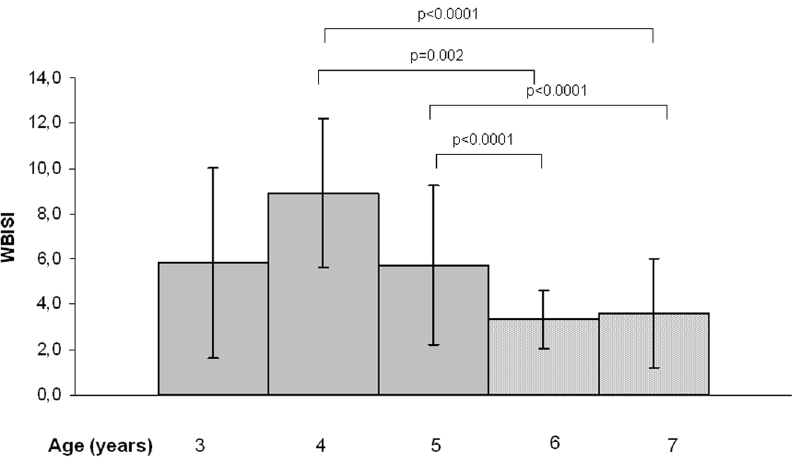
Figure 2. Mean values of Whole Body Insulin sensitivity (WBISI) by years of age in preschoolers and school age obese children.